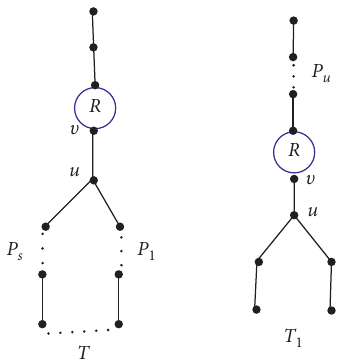
Figure 6: The trees T and T